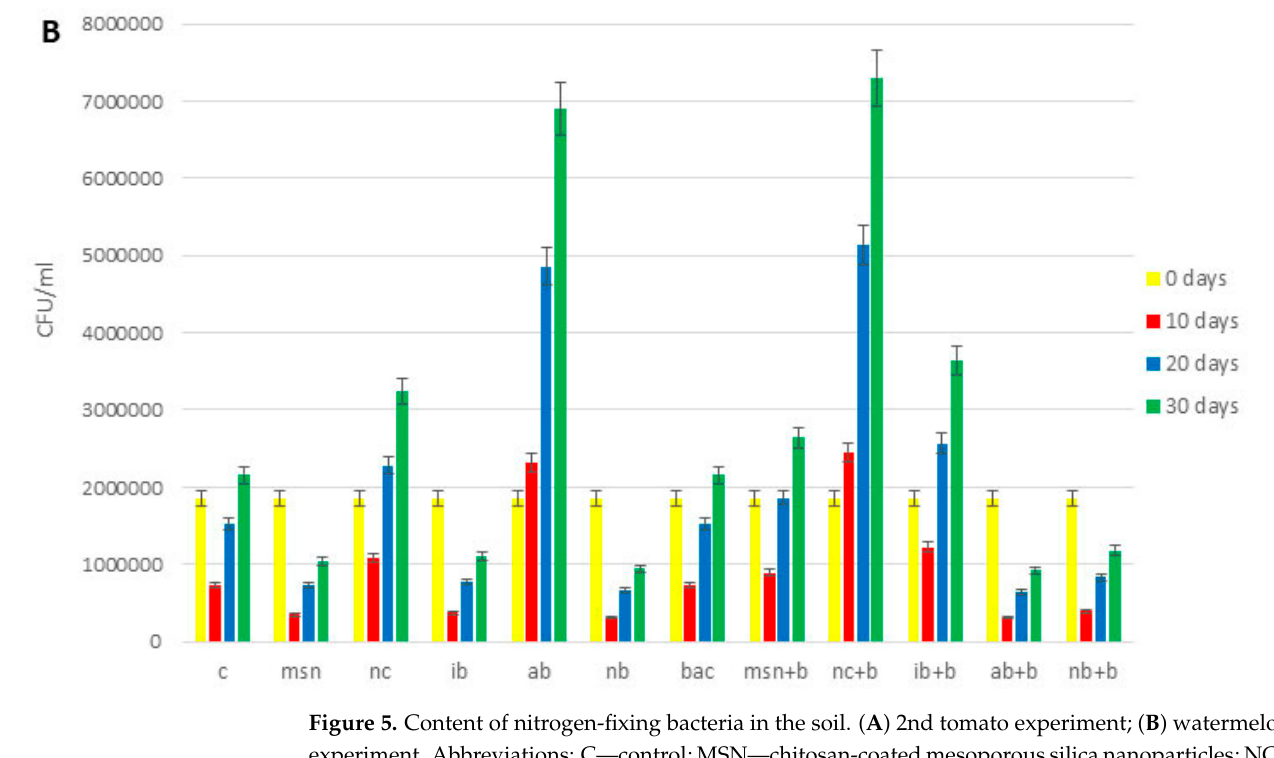
Figure 5. Content of nitrogen-fixing bacteria in the soil. ( A ) 2nd tomato experiment; ( B ) watermelon